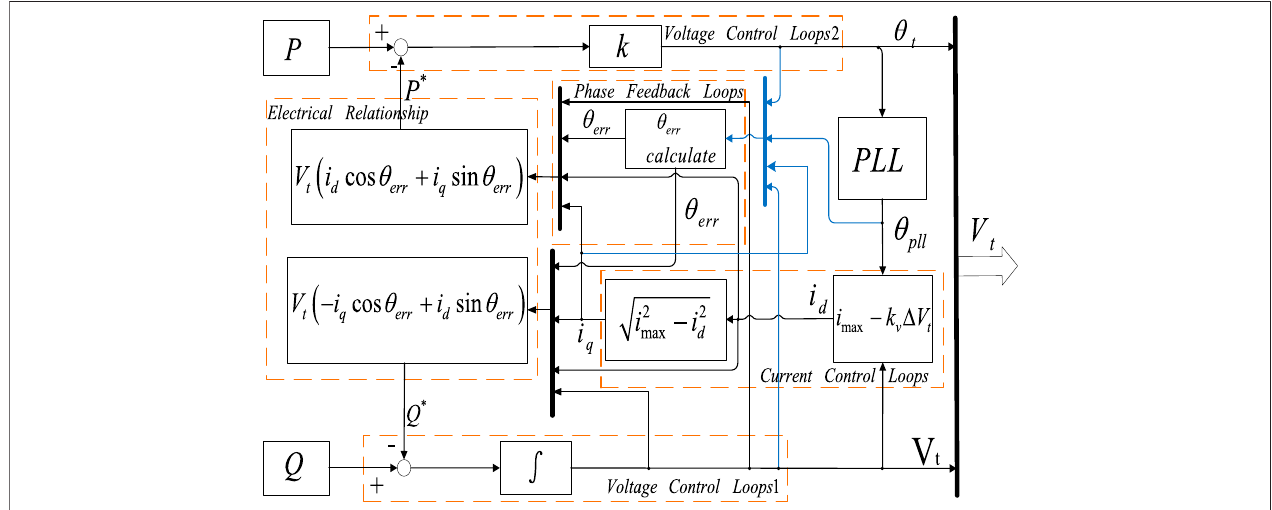
FIGURE 4 | Improved amplitude – phase motion equation model.